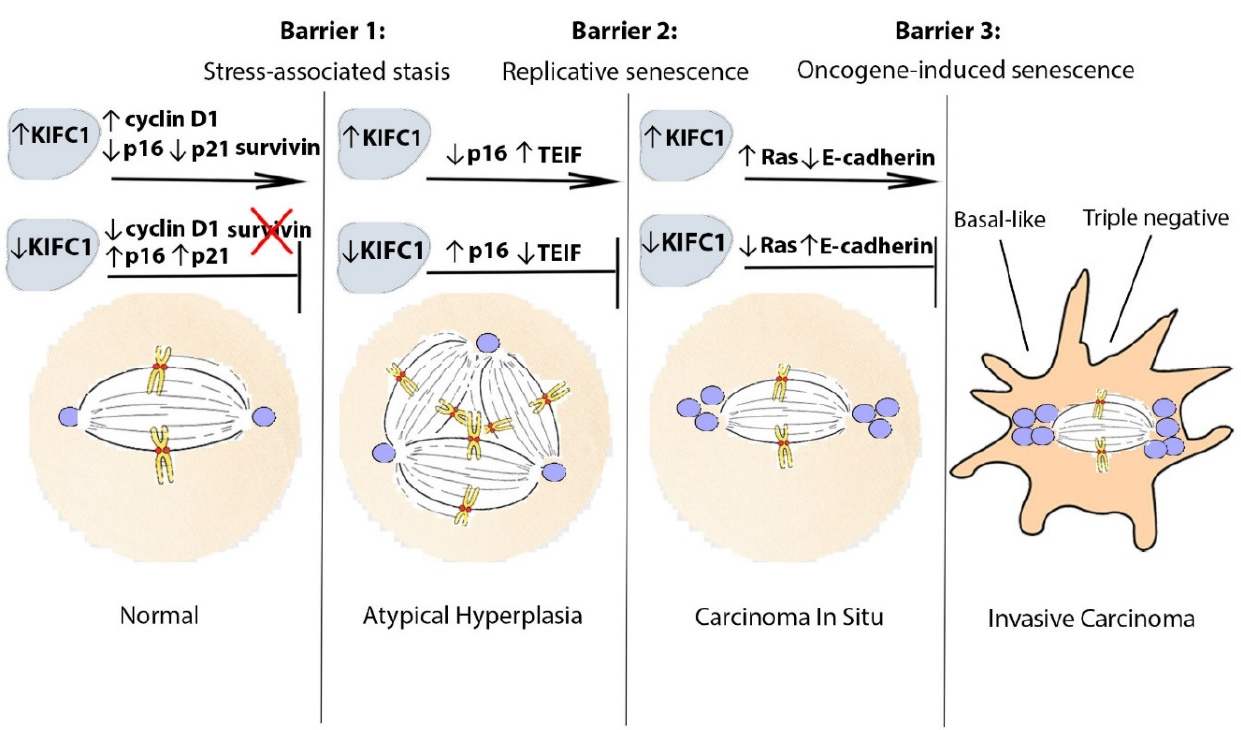
Figure 1. Proposed model of KIFC1-mediated breast neoplastic progression. KIFC1 may assist pre-neoplastic and pre- invasive cells to progress by facilitating their bypassing of tumor-suppressive barriers to malignant transformation and immortalization. To bypass the first barrier (stress-associated stasis), KIFC1 may upregulate cyclin D1 and/or survivin levels or be upregulated as a result of p16 and p21 loss to facilitate survival of centrosome-amplified cells. To bypass the second barrier (replicative senescence), in addition to being upregulated as a result of p16 loss, KIFC1 may be upregulated as a result of telomere dysfunction-mediated induction of TEIF to allow centrosome-amplified cells to persist. Alternatively, KIFC1 could promote selective survival of cells that can reactivate telomerase. To bypass the last barrier (oncogene-induced senescence), KIFC1 may induce the survival of cells with Ras signaling-induced CA. In addition, KIFC1 may promote the loss of E-cadherin as a result of causing cytoarchitectural reorganization, which may impart invasive capabilities to pre-invasive cells. Abbreviations: KIFC1, Kinesin family member C1; TEIF, telomerase transcriptional elements-interacting